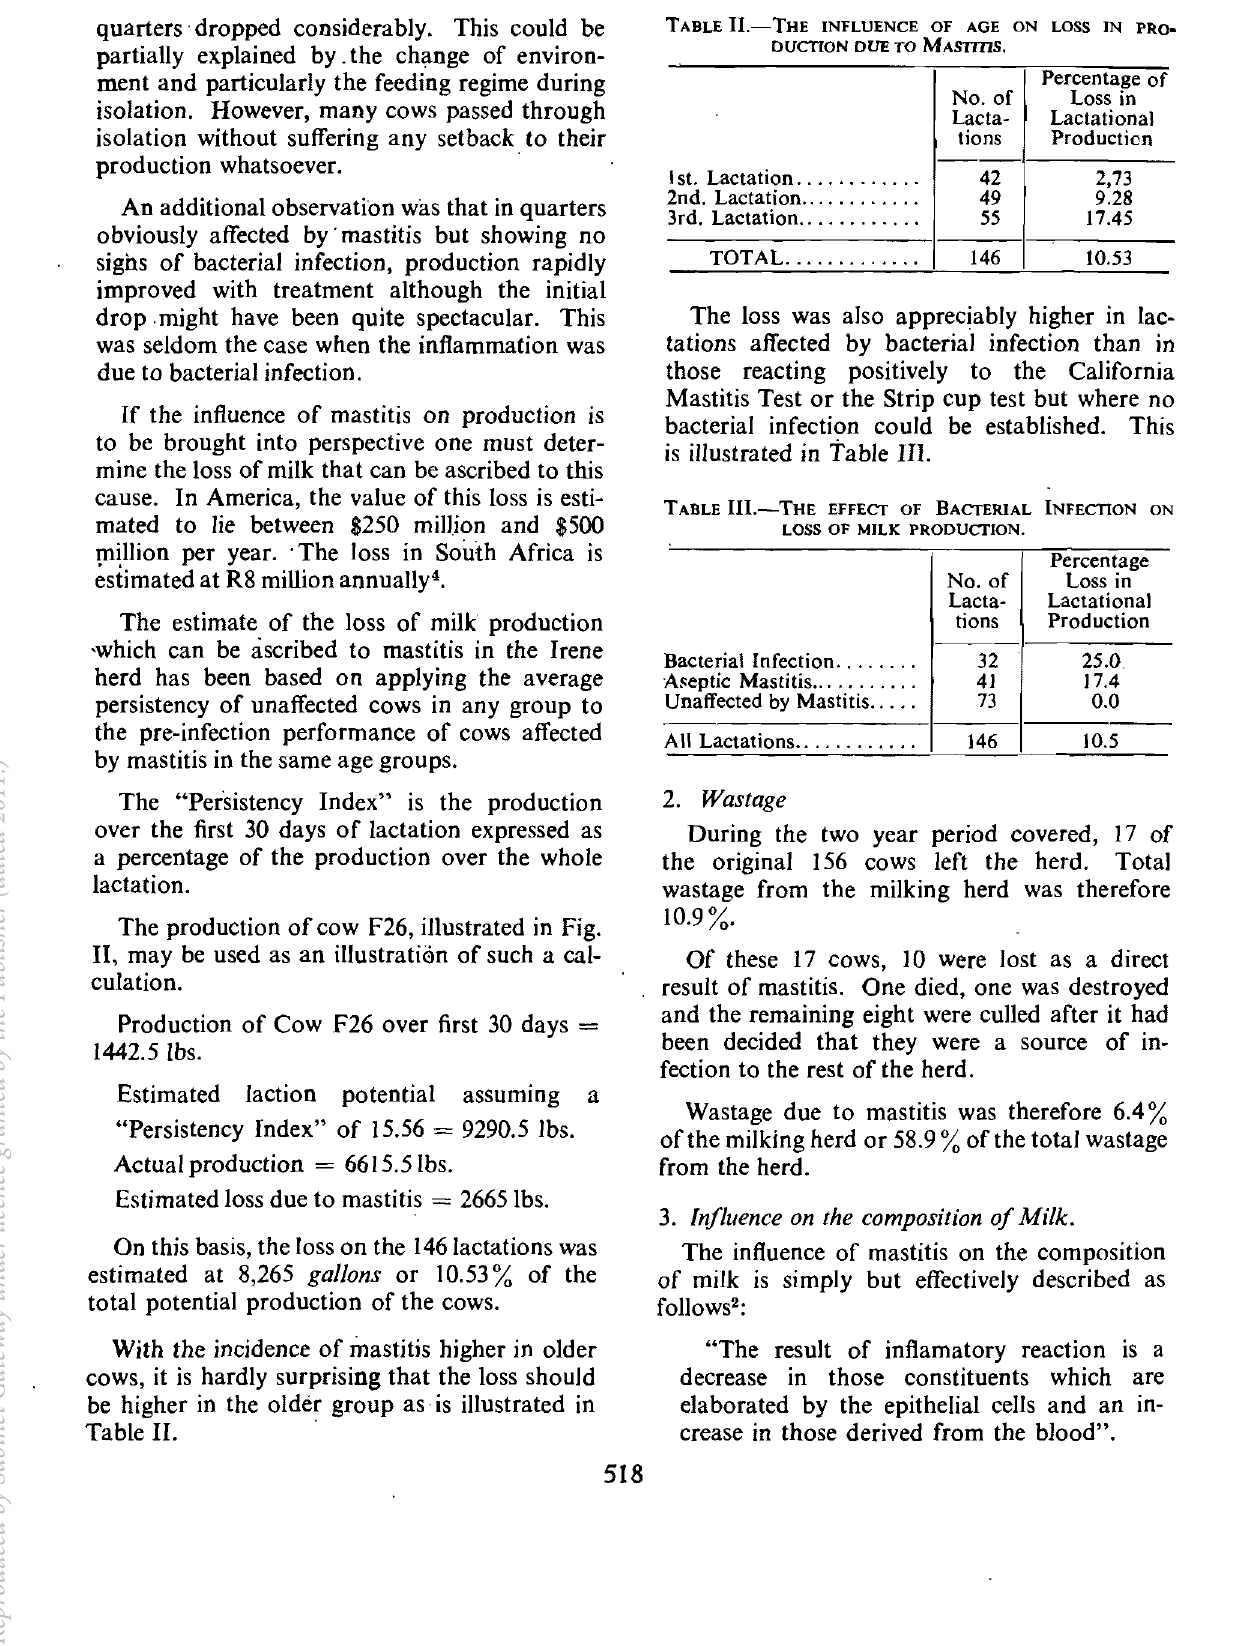
TABLE n.-THE INFLUENCE OF AGE ON LOSS IN PRO DUCTION DUI! TO